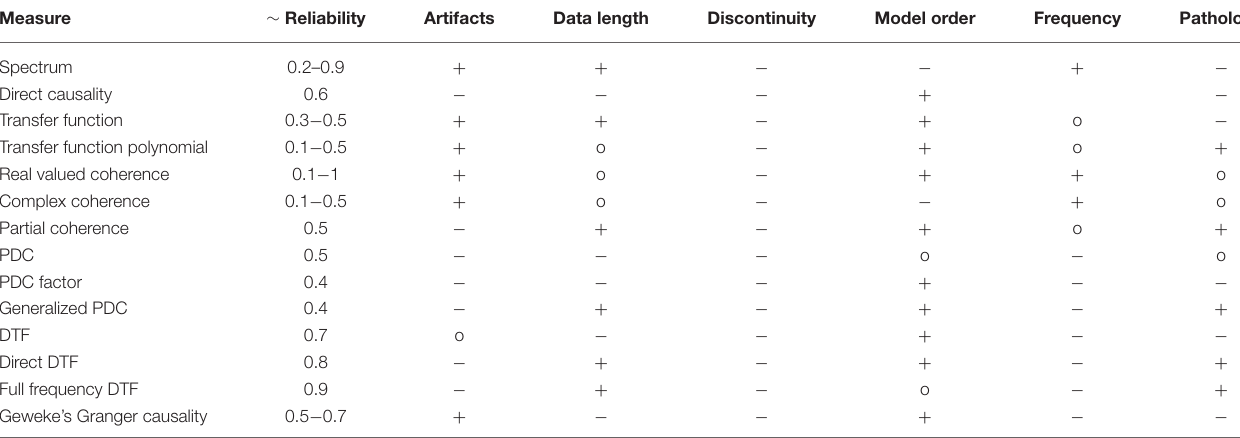
TABLE 3 | Qualitative overview of relevance of moderators for reliability of